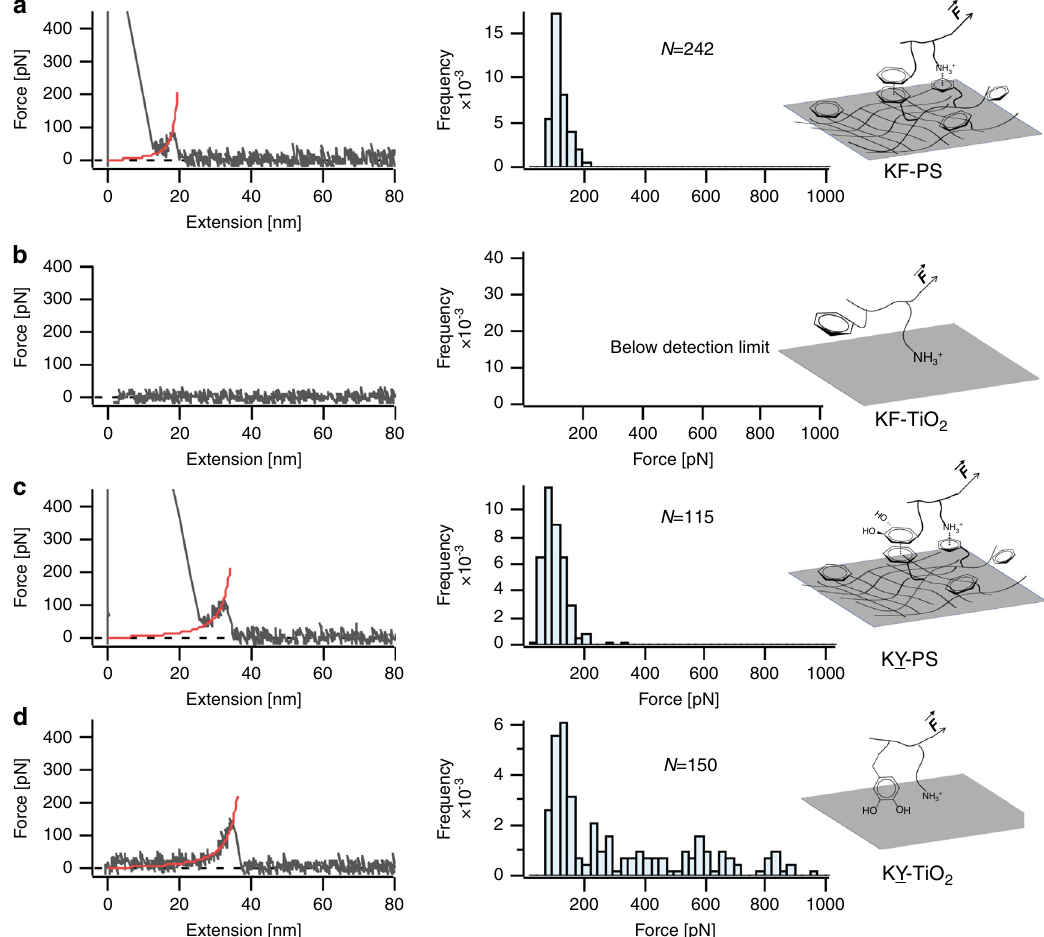
Fig. 4 SMFS results for the interaction of (KF) and (KY) dipeptides with PS and TiO 2 . Representative F – X curves (left) and rupture force distribution (right) are shown for interaction of (KF) in a , b and for interaction of (KY) in ( c , d ). N values represent the total number of rupture events used to plot the histograms. The red lines in the F – X curves correspond to the WLC fi tting. Schematic illustrations for the peptide – surface interactions are shown on the right. For comparison purposes, d is reproduced here from the same dataset as shown in Fig. 3a. Source data are provided as a Source data fi le.